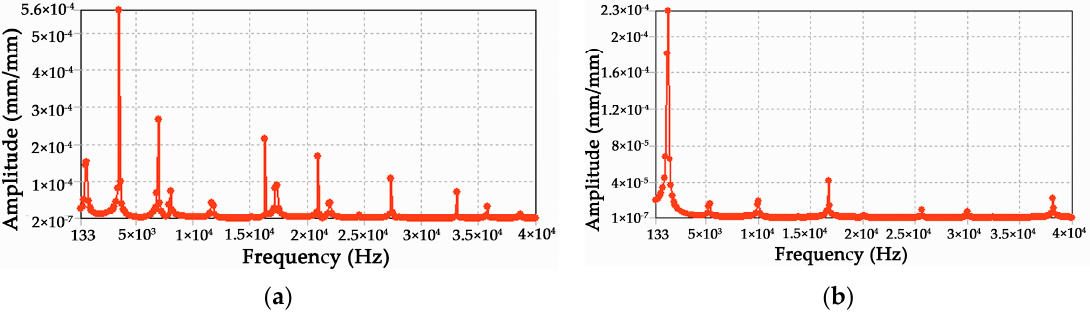
Figure 8. Harmonic response of the diaphragm under the measuring force component F x ( a ) and F z ( b ).